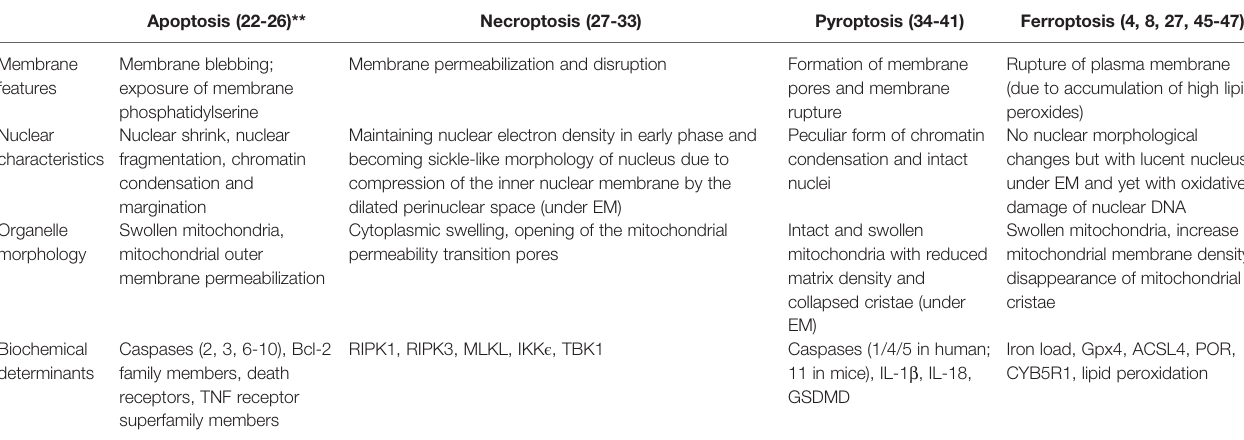
TABLE 1 | Distinguished features of different subtypes of cell